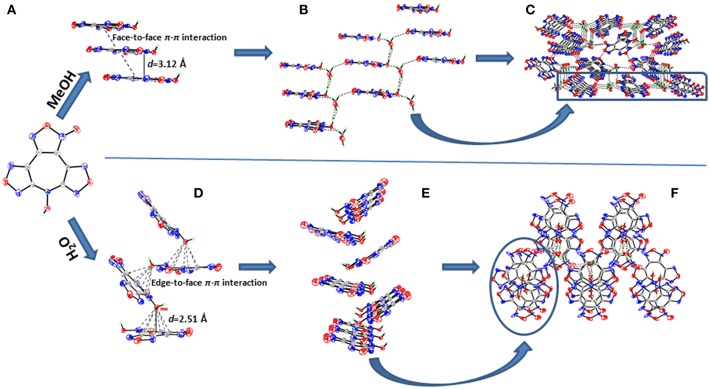
(A) Parallel face-to-face arrangements within 4·MeOH. (B) Hydrogen-bonding interactions between MeOH and adjacent 4. (C) Layered three-dimensional packing of 4·MeOH. (D) Edge-to-face π-π interactions within 4·H2O. (E) Zigzag-shaped two-dimensional sheet within 4·H2O. (F) Three-dimensional packing of 4·H2O.